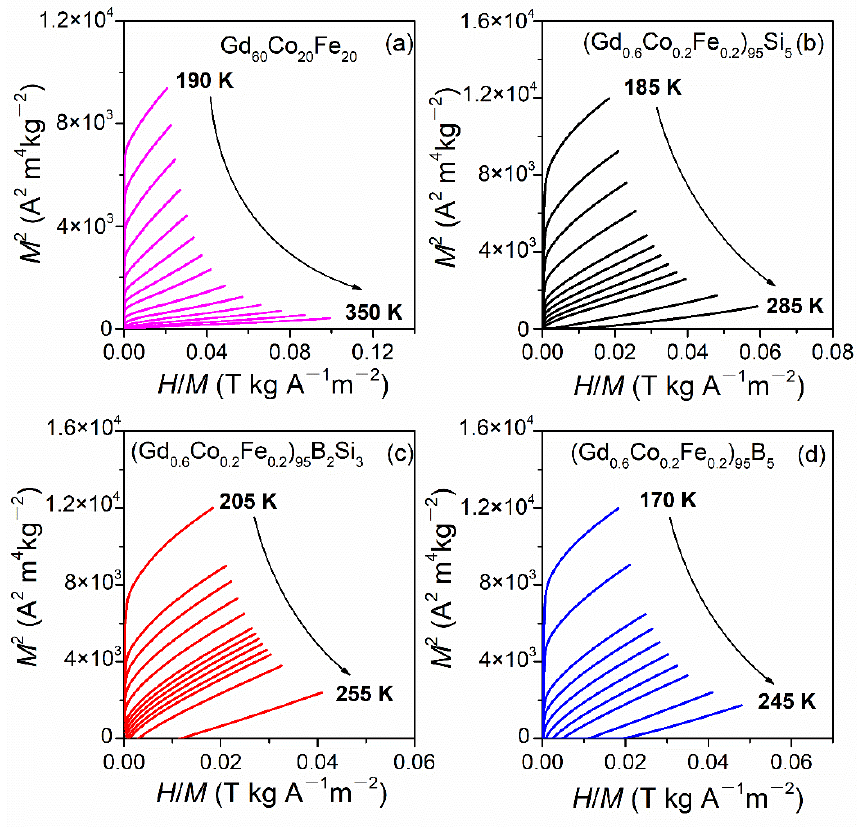
Figure 5. Arrott plots of amorphous alloys, ( a ) Gd 60 Co 20 Fe 20 and (Gd 0.6 Co 0.2 Fe 0.2 ) 95 B x Si 5−x with x = ( b ) 0, ( c ) 2, and ( d ) 5, derived from the M – H